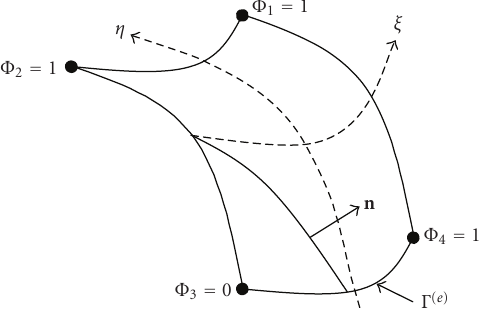
Figure 3: Finite element band